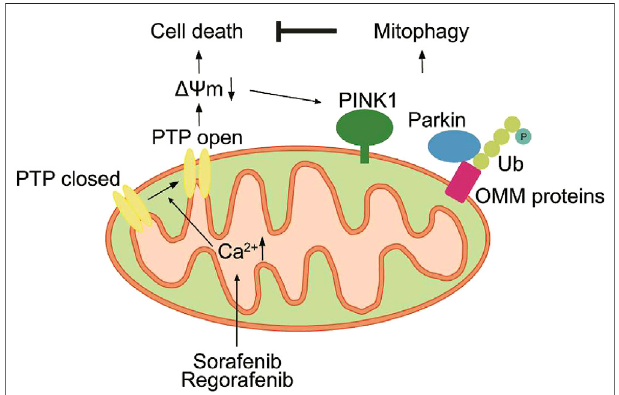
FIGURE 10 | Sorafenib and regorafenib induce mPTP opening due to mtCa 2+ overload. The opening of the mPTP induces cell death and the collapse of ΔΨ m. However, loss of ΔΨ m activates PINK1-mediated mitophagy, which in turn alleviates sorafenib- and regorafenib-induced cell